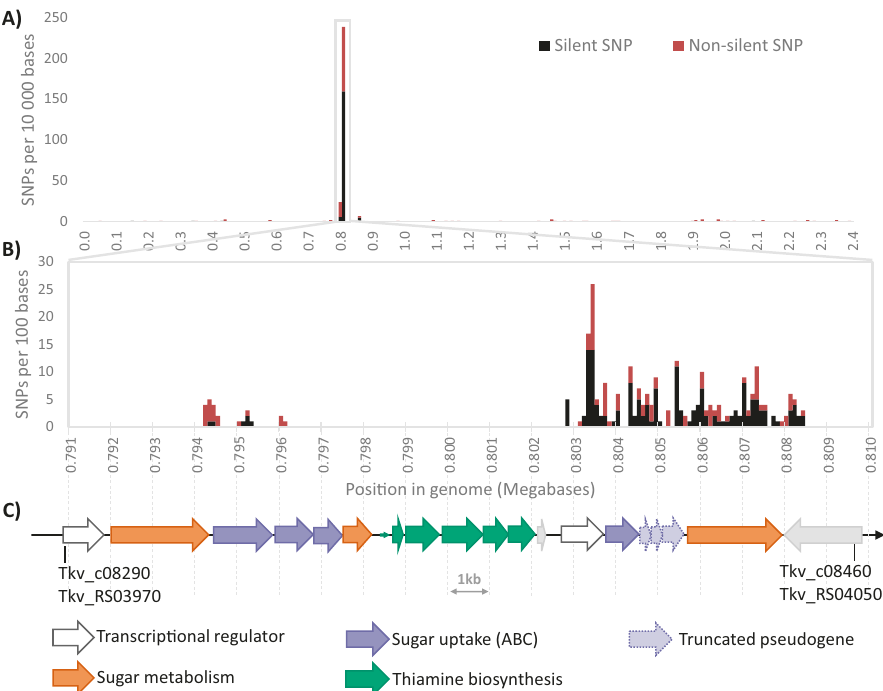
Fig. 1 Results of SNP sequencing analysis of the CO-strain of T. kivui . Frequency of SNPs in the genome of the CO-strain vs. the wild type: A per 10,000 bases in the entire genome, B per 100 bases in the region containing the majority of SNPs, black are silent SNPs that do not lead to a change in amino acid sequence, red are non-silent mutations. C Genes present in this region of the genome and their probable